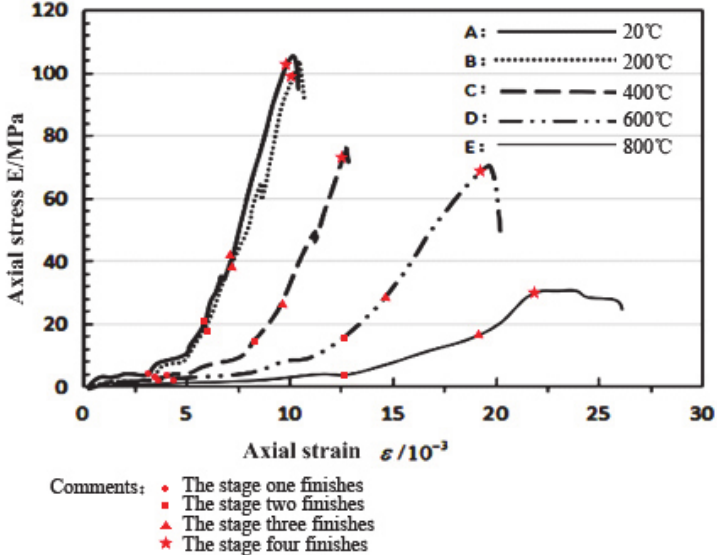
Figure 6: Stress-strain curves of granite specimens heated at different temperatures in uniaxial compression